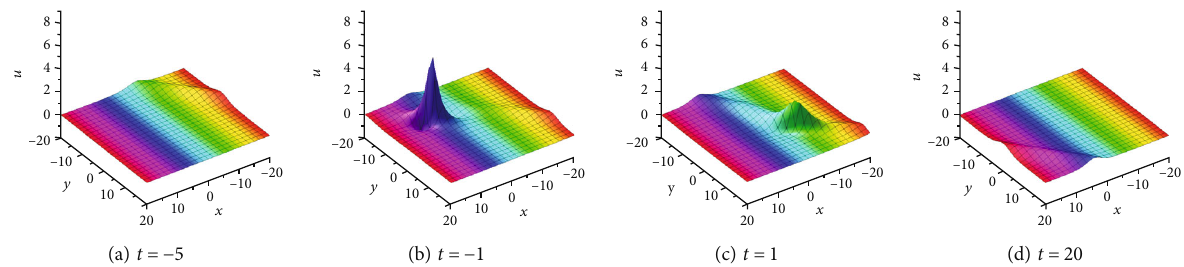
Figure 11: Lump rebound after absorption by single soliton.